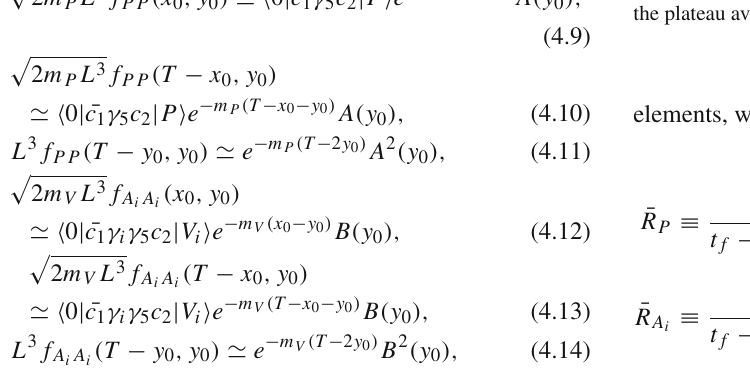
Fig. 1 Effective quantity R P , defined in (4.15), from which the decay constants are extracted. The results shown in the figure are obtained on the N f = 2 ensemble W at β = 6 . 0. The horizontal error band indicates the plateau average ¯ R P with its statistical